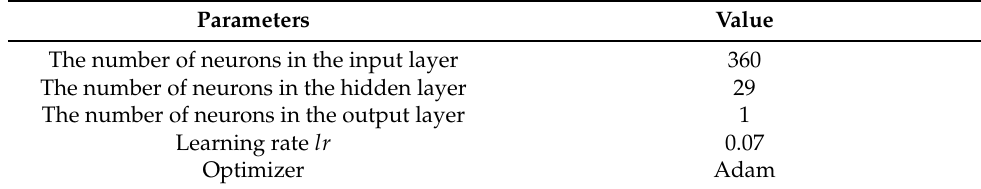
Table 3. Hyperparameter configuration of